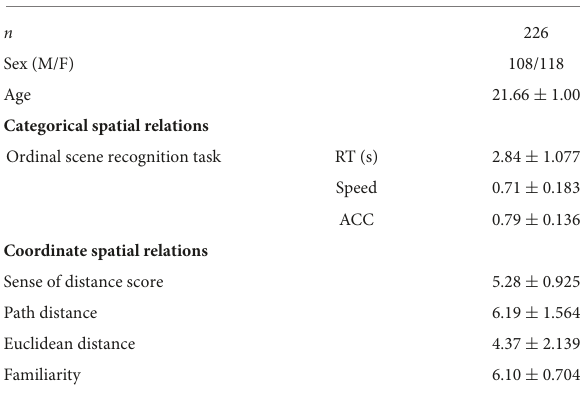
TABLE 1 Demographic information and descriptive statistics of behavioral